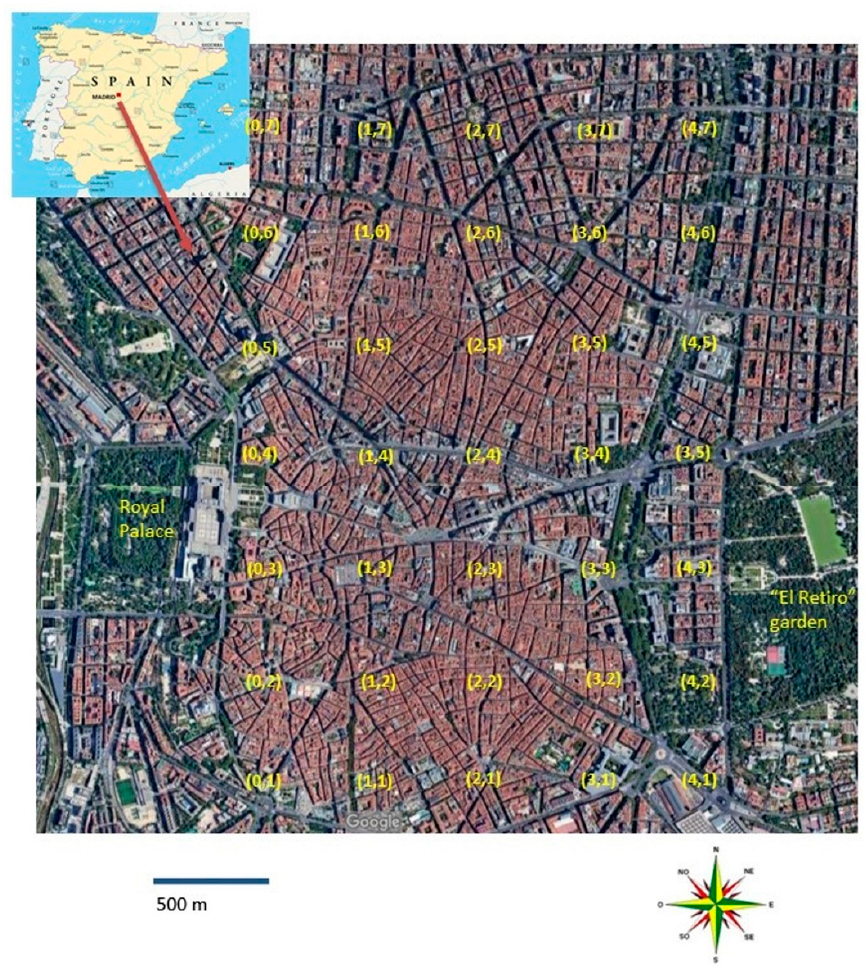
Figure 1. Map of Spain with the city of Madrid in the center of which it has been sampled Location of 35 street dust sampling sites in Madrid. Systematic sampling with 500 m between sites.